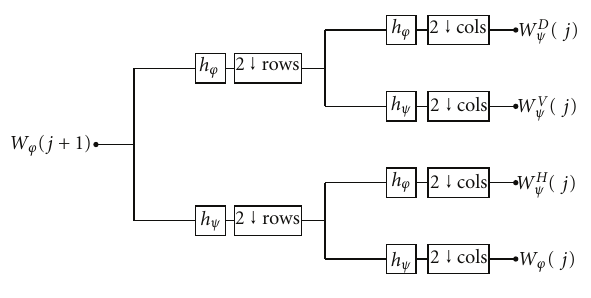
Figure 2: 2D wavelet